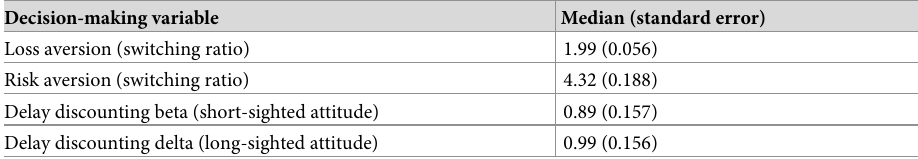
Table 4. Descriptive statistics for the decision-making variables.